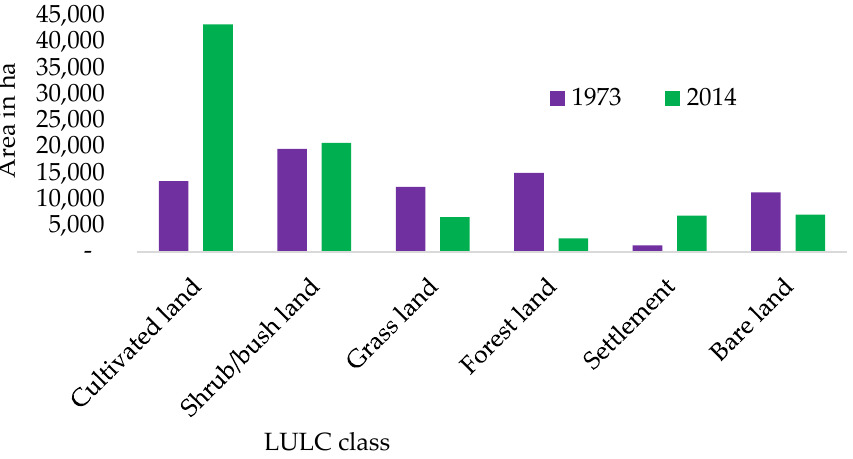
Figure 6. Changes in LULC from 1973 to 2014 in Toke Kutaye, Ethiopia (Source of data: Tolessa et al. [56], but figure done by authors).